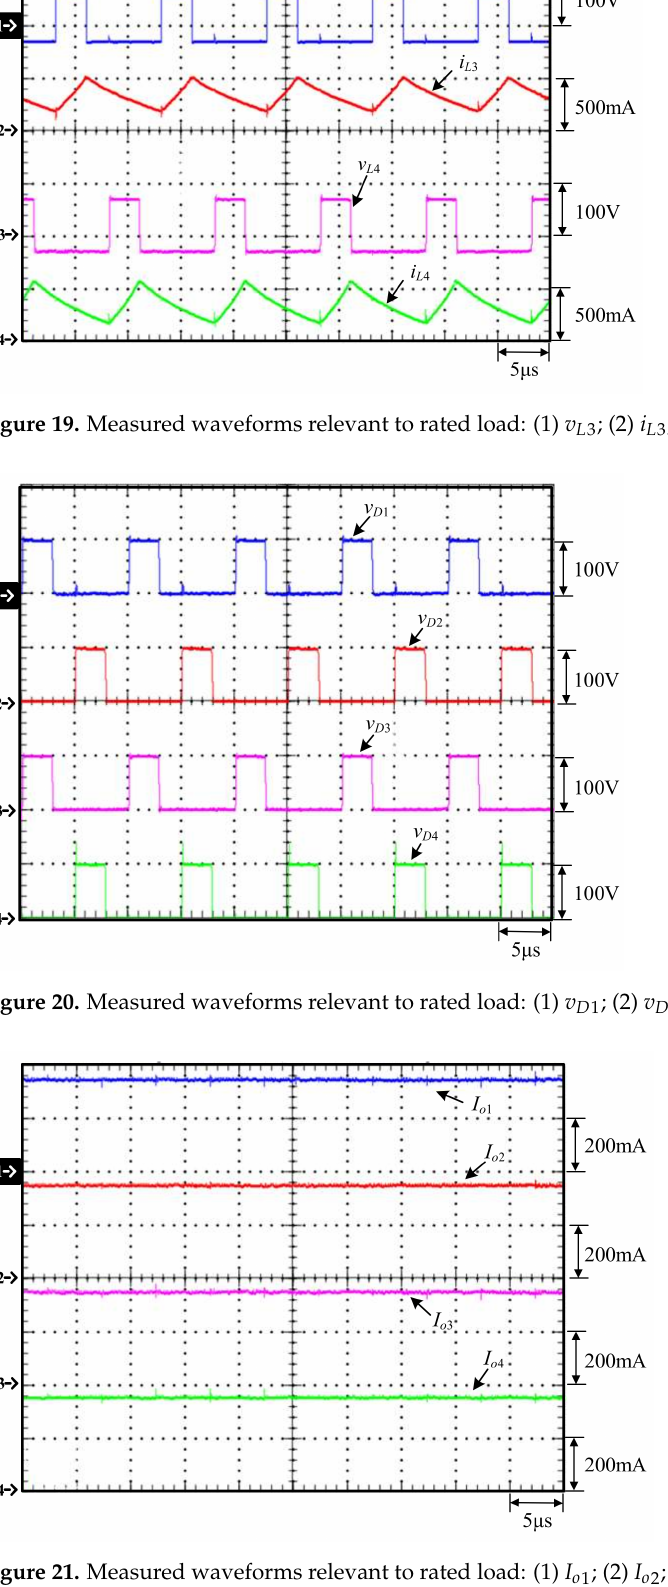
Figure 21. Measured waveforms relevant to rated load: (1) I o 1 ; (2) I o 2 ; (3) I o 3 ; (4) I o 4